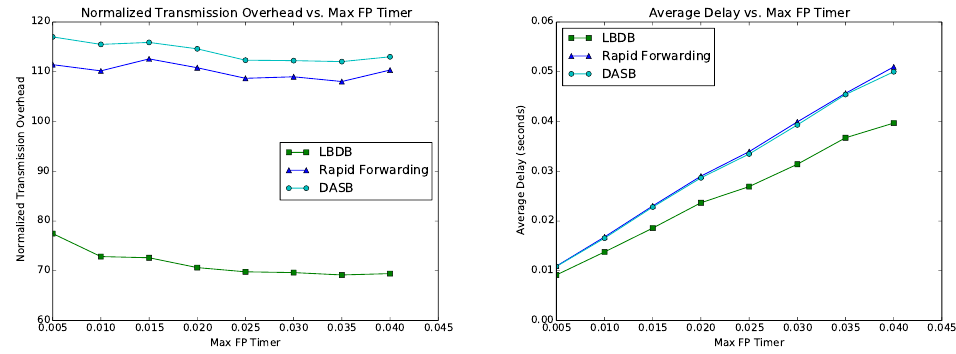
Figure 13. Impact of Max Forwarding Priority (FP)